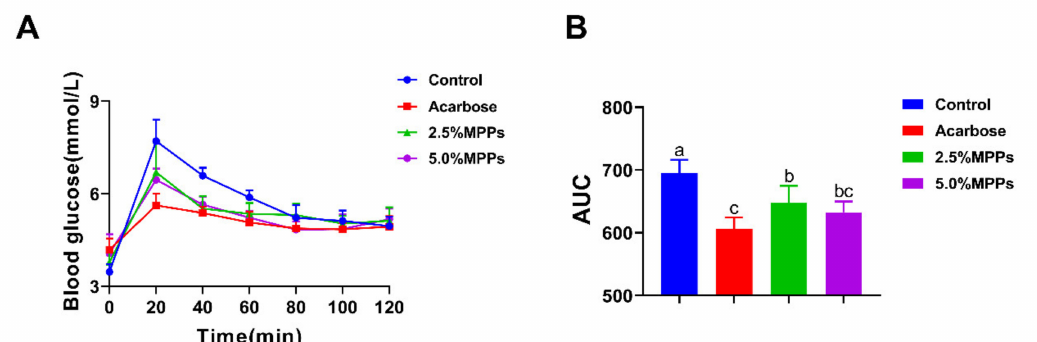
Figure 4. Postprandial change of blood parameters in rats with the presence of MPPs: ( A ) Blood glucose in rats treated with MPPs ( n = 6); ( B ) AUC of blood glucose in rats treated with MPPs ( n = 6). Data were analyzed by ANOVA and Duncan’s multiple-range test. Different letters mean significant differences ( p <